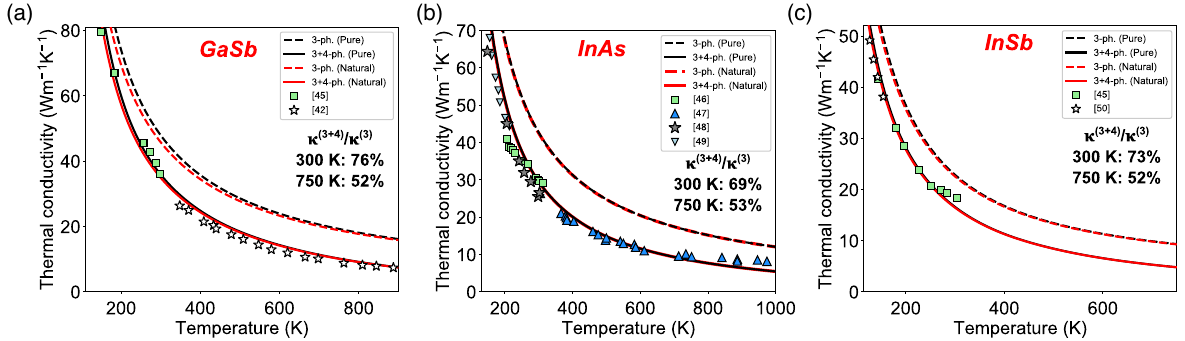
ð 3 Þ ð 3 þ 4 Þ ð 3 Þ ð 3 þ 4 Þ (dashed black line), κ (solid black line), κ (dashed red line), and κ (solid red line) Pure Pure Nat Nat